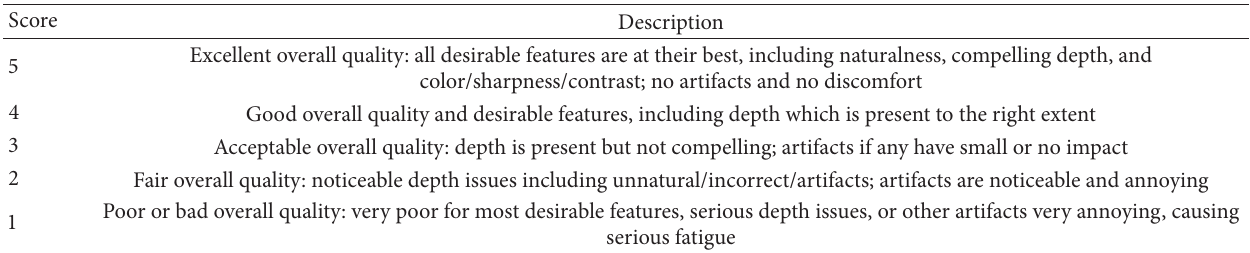
Table 1: Guidelines used in this research.